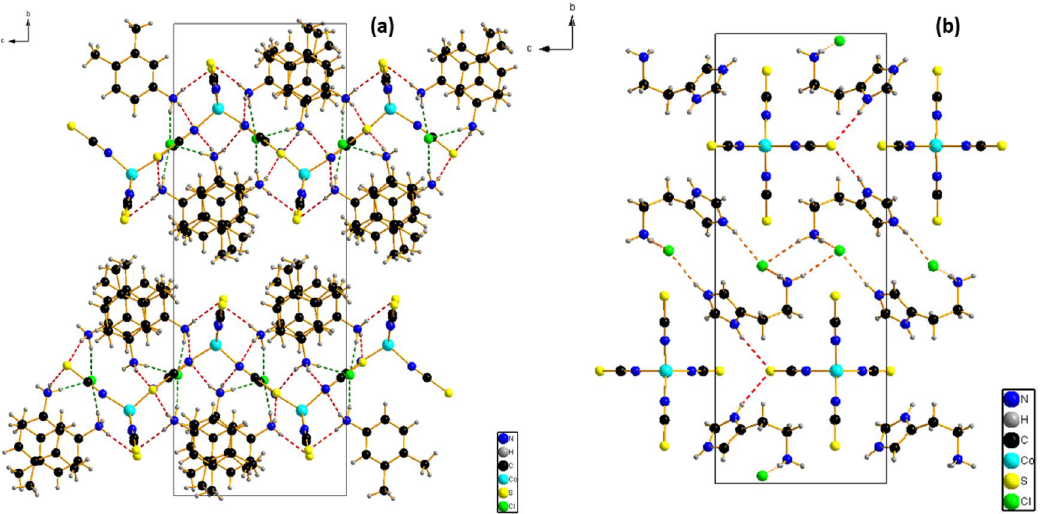
Figure 2. Projection along the a -axis of the structure of ( a ) {[Co(SCN) 4 ] (C 8 H 12 N) 3 }·Cl and ( b ) {[Co(SCN) 4 ] (C